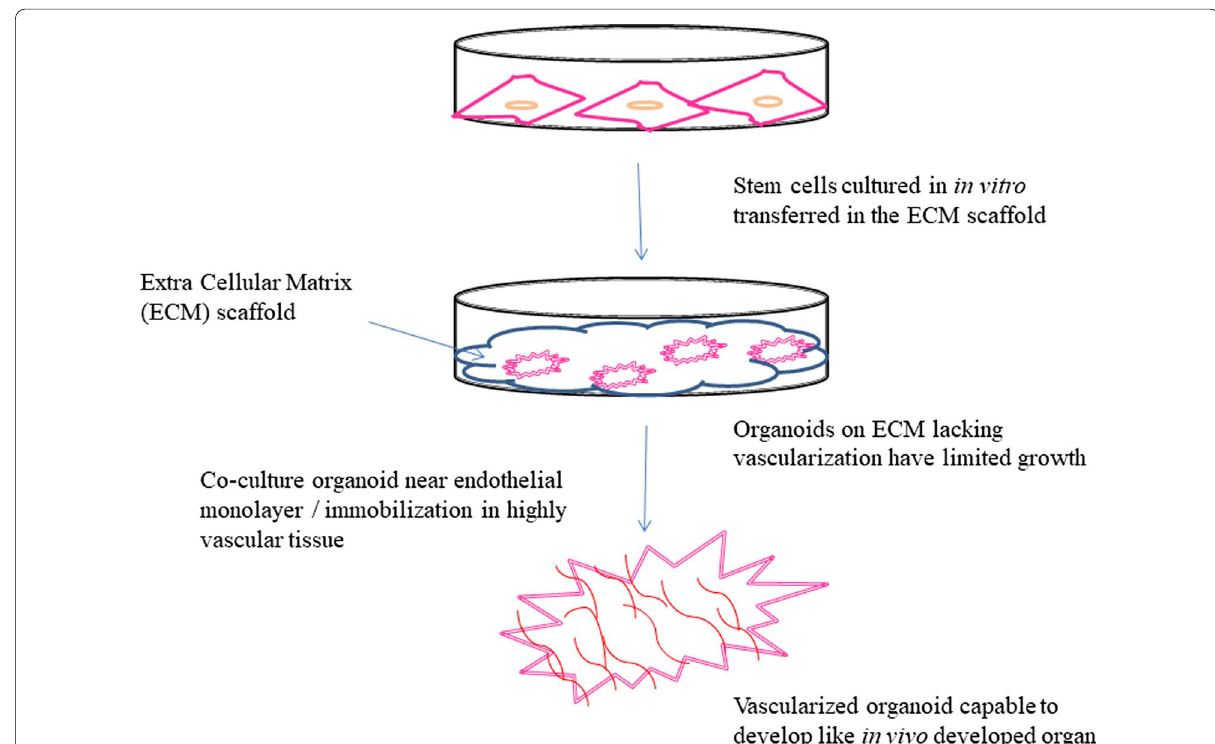
Fig. 3 Vascularized organoid development from stem cells on the extracellular matrix (ECM) scaffold by co-culturing with endothelial cells or immobilizing the developed organoid in highly vascular